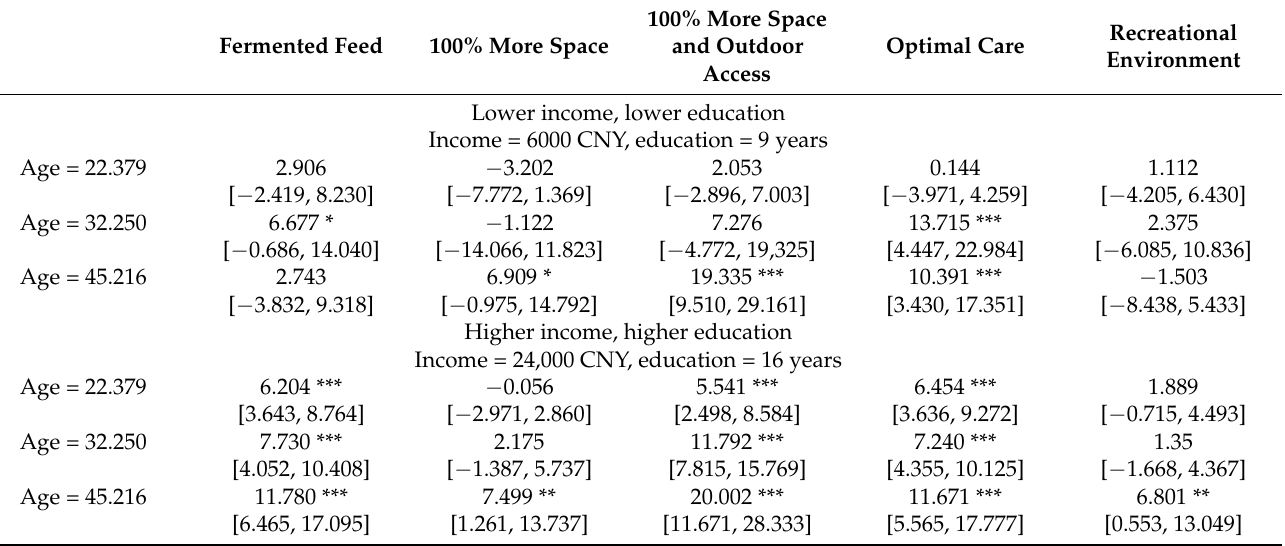
Table 6. Estimates of consumers’ willingness to pay by six